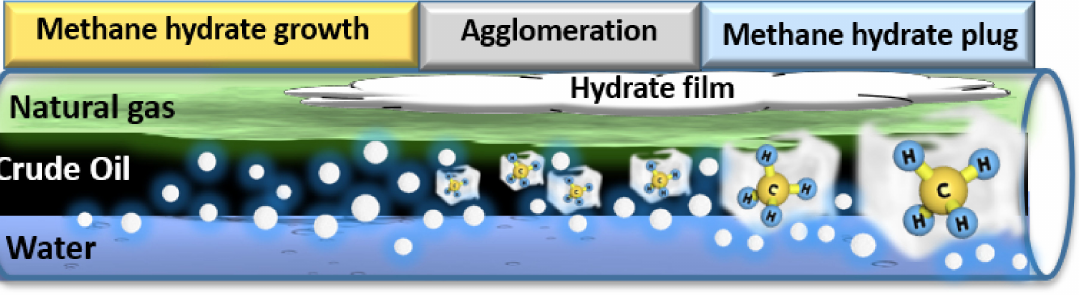
Figure 2. Methane hydrate flow process in a crude oil